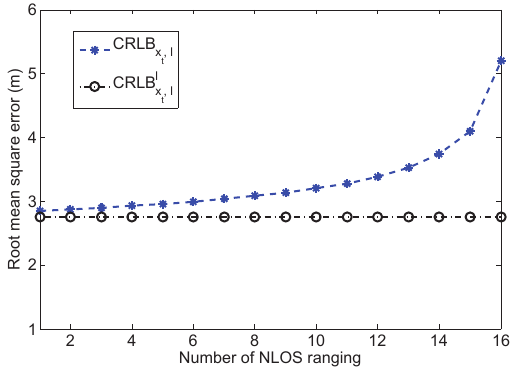
Figure 5. The impact of the number of l